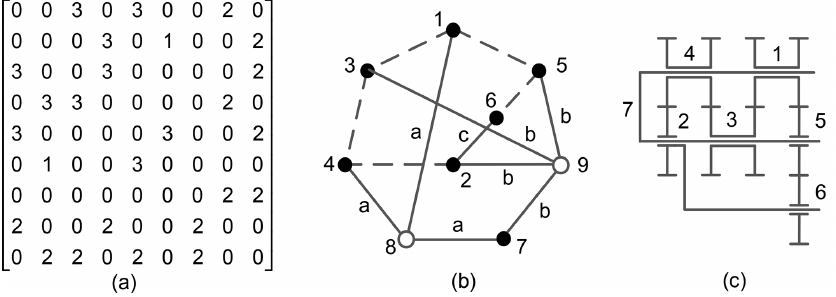
Figure 7. Case 3 of the DPGT. (a) The adjacency matrix, (b) d graph, and (c) mechanism diagram.